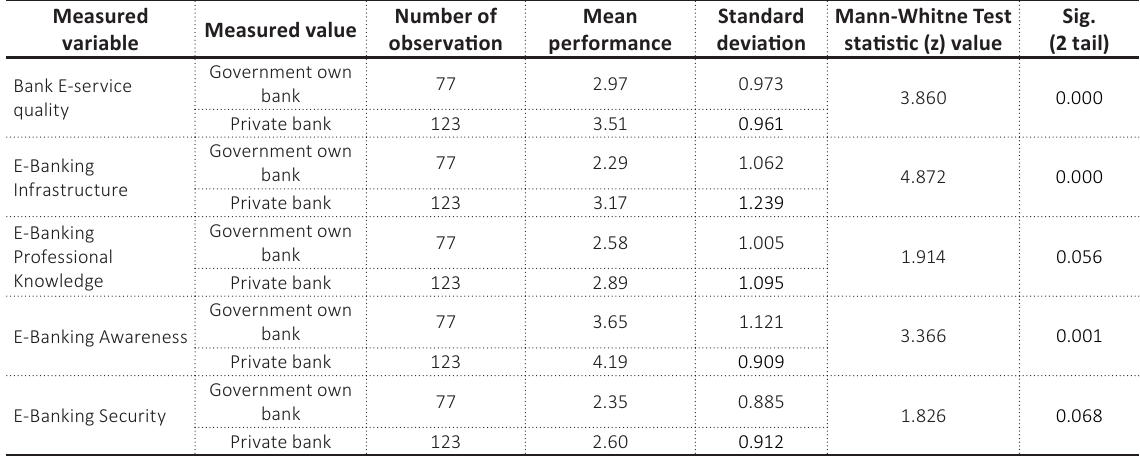
Table 6. Mann-Whitney test for government-owned and private banks Number of Measured Mean Measured value variable observation performance